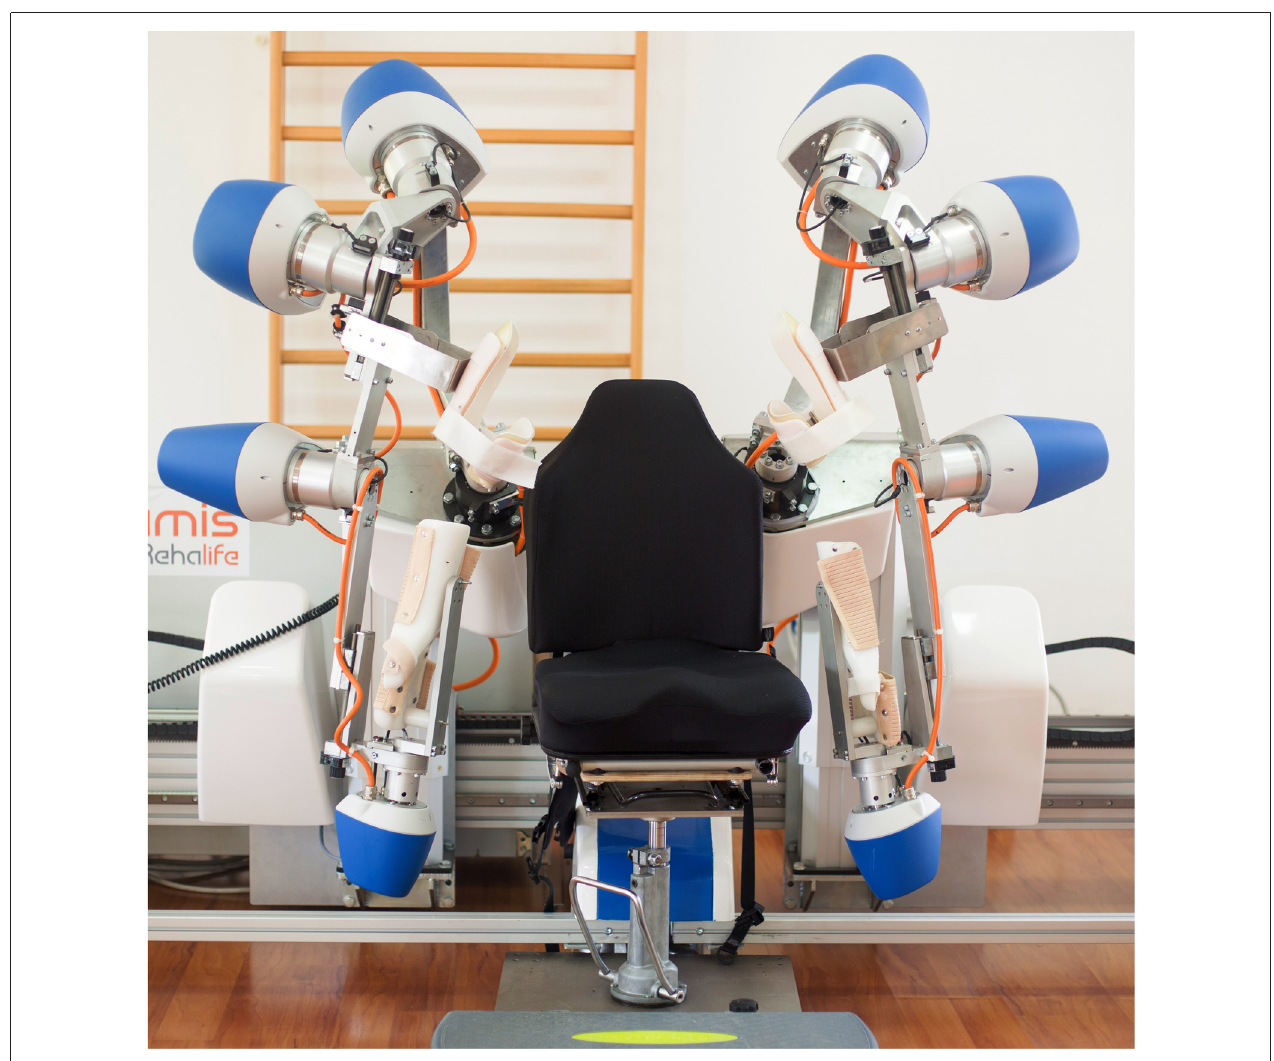
FIGURE 2 | The robotic-assisted device called Automatic Recovery Arm Motility Integrated System